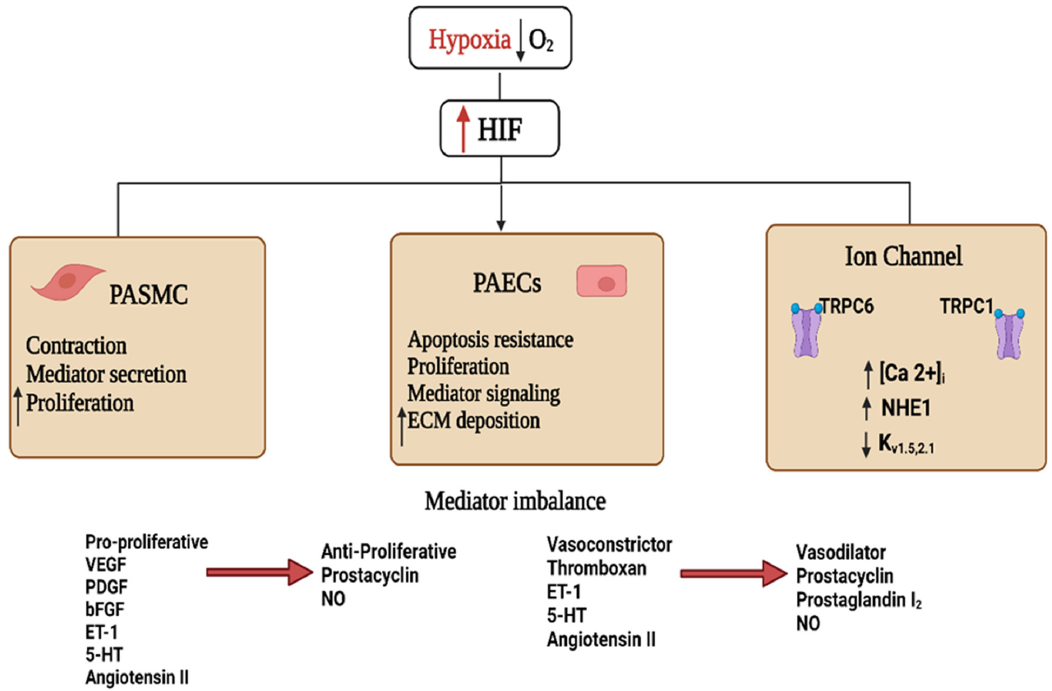
Figure 2. Schematic diagram showing the hypoxia-inducible factor 1 (HIF1)-activated mechanisms involved in pulmonary hypertension. Decreased blood O 2 partial pressure ( ↓ pO 2 = hypoxia) acts as a signal in the pulmonary vasculature. Increased HIF stability and signaling during hypoxia activate cellular pathways culminating in vascular endothelial and smooth muscle dysfunction. These effects include increased secretion of vaso-modulators and extracellular matrix (ECM), depolarization of pulmonary artery vascular smooth muscle cells (PAVSMCs) via reduction of outward K + and enhanced inward Ca 2+ currents, and upregulated Na + /H + exchanger isoform 1 (NHE1) function, increasing [Ca 2+ ]i, contractility, and proliferation of PAVSMCs. The imbalance between vasodilator and vaso- constrictor signals and the altered cell proliferation orchestrates the pathological signaling events leading to vascular remodeling and the development of pulmonary hypertension. Abbreviations: bFGF, basic fibroblast growth factor; ET-1, endothelin 1; 5-HT, serotonin; NO, nitric oxide; PDGF, platelet-derived growth factor; PASMCS, pulmonary artery smooth muscle cells; PAECs, pulmonary artery endothelial cells; VEGF, vascular endothelial growth